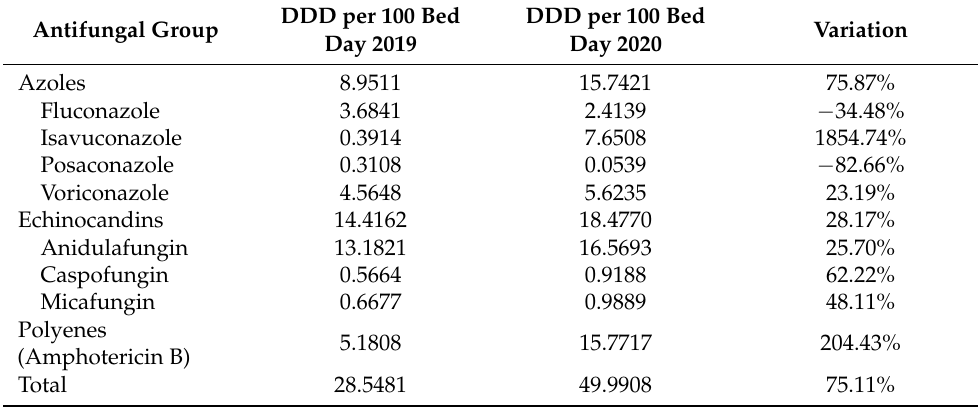
Table 3. Use of antifungals in 2019 and 2020 in the